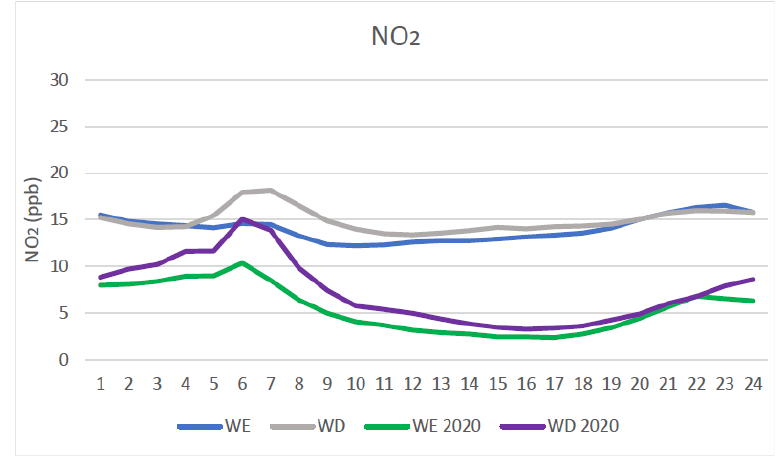
Figure 7. Nitrogen dioxide (NO 2 ) for the average period April to June 2010 – 2019 for weekends (WE) and weekdays (WD) and for April to June 2020 (WE 2020, WD 2020) at Toronto East.